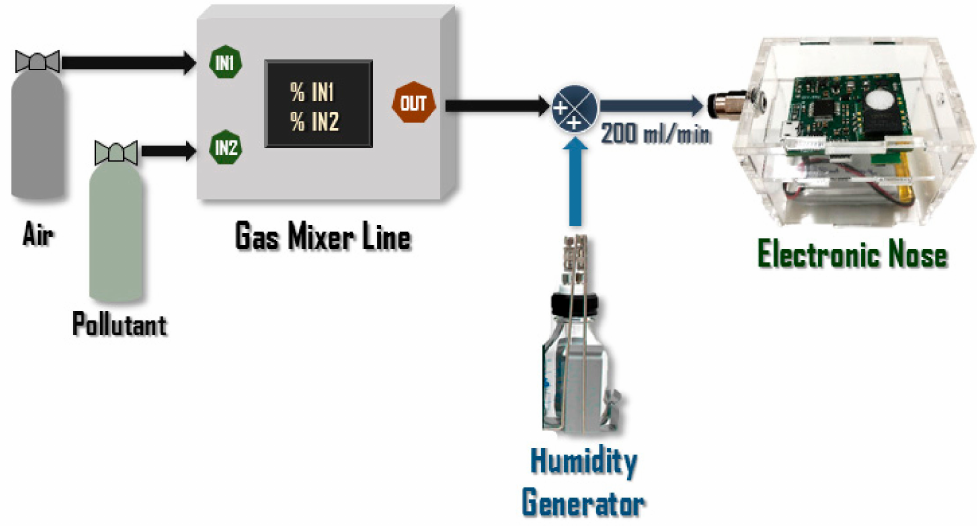
Figure 5. Measurements